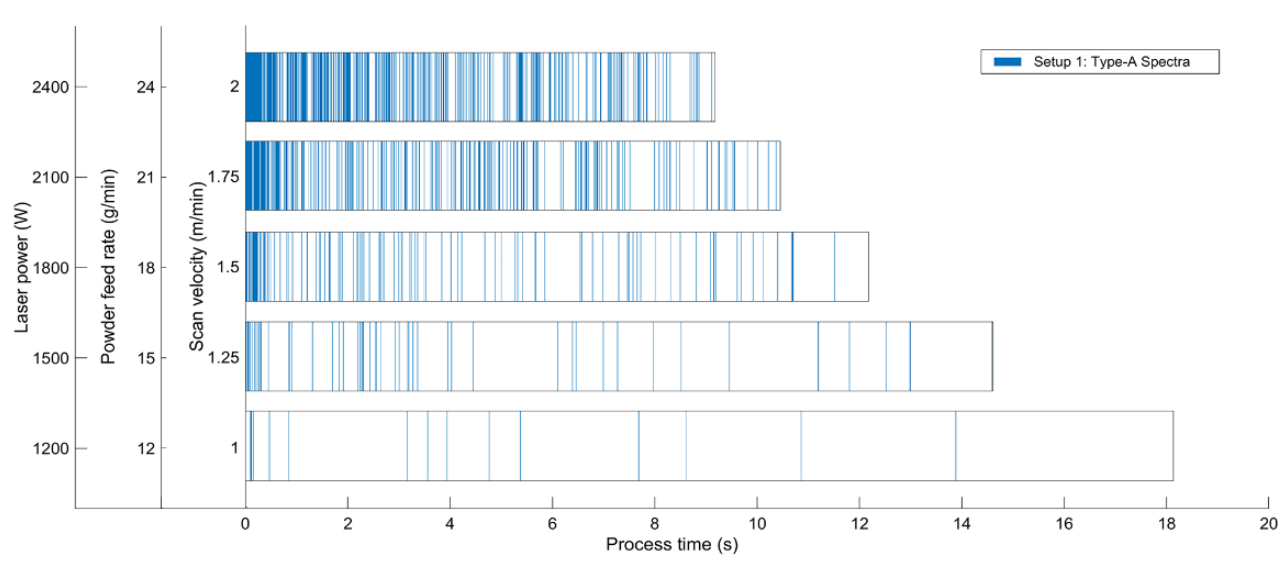
Figure 8. Incidence of detected type A spectra for setup 1 vs. process time; each blue line represents a type A spectrum whereas for the white ranges, merely type B spectra occurred. Note that the process time decreases with increasing scan velocity, since the process parameters were adapted to obtain a constant linear energy and linear mass as described in Section 2.